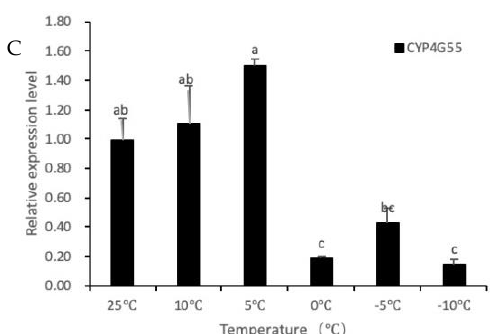
Figure 5. Relative expression levels of HSP21 under various temperatures in adult D. valens using different reference genes. ( A – C ) 18S rRNA , RPS18 and CYP4G55 were used as reference genes, respectively. Data are mean ± SE. Different letters above bars mean significant differences ( p < 0.05, Duncan’s test).